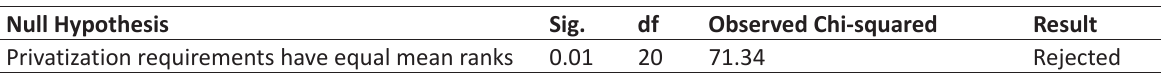
Table 3. Kruskal-Wallis one-way analysis of variance Null